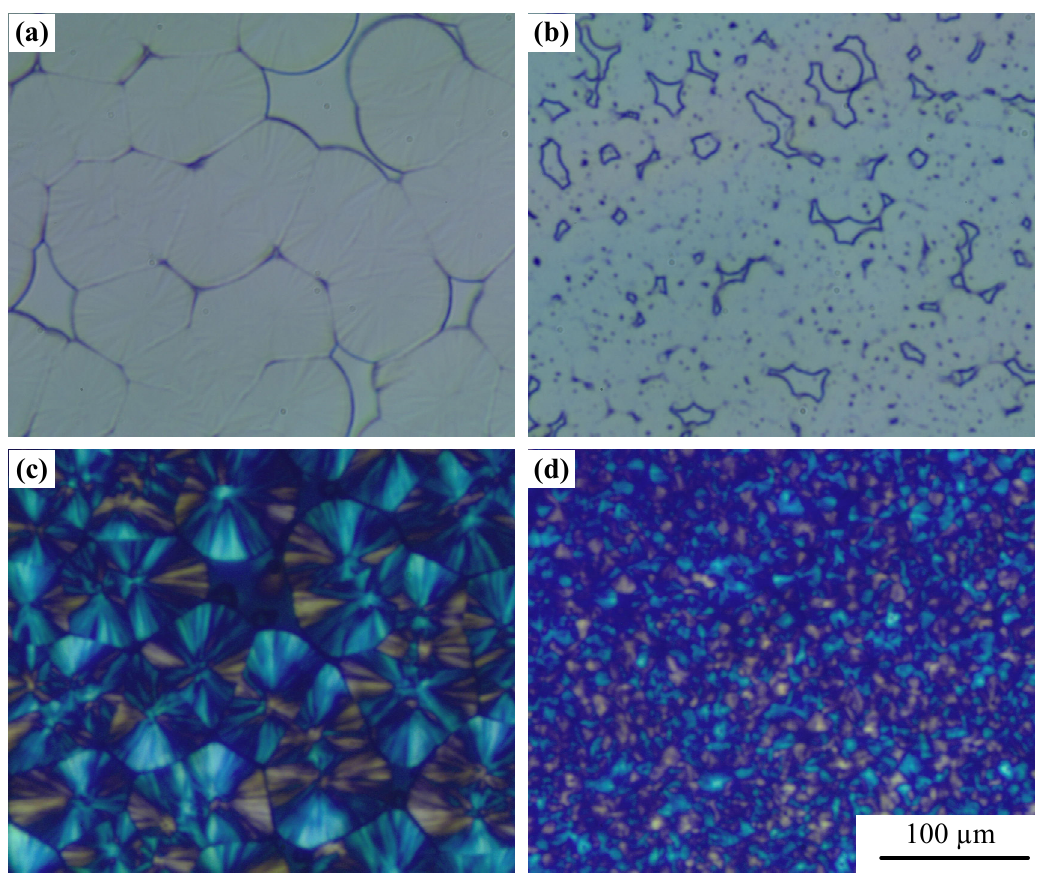
Figure 3. Grain morphology of PP and PP/GN nanocomposite under air and 140 °C, ( a ) and ( c ) show PP morphology, ( b ) and ( d ) present PP/GN nanocomposite.